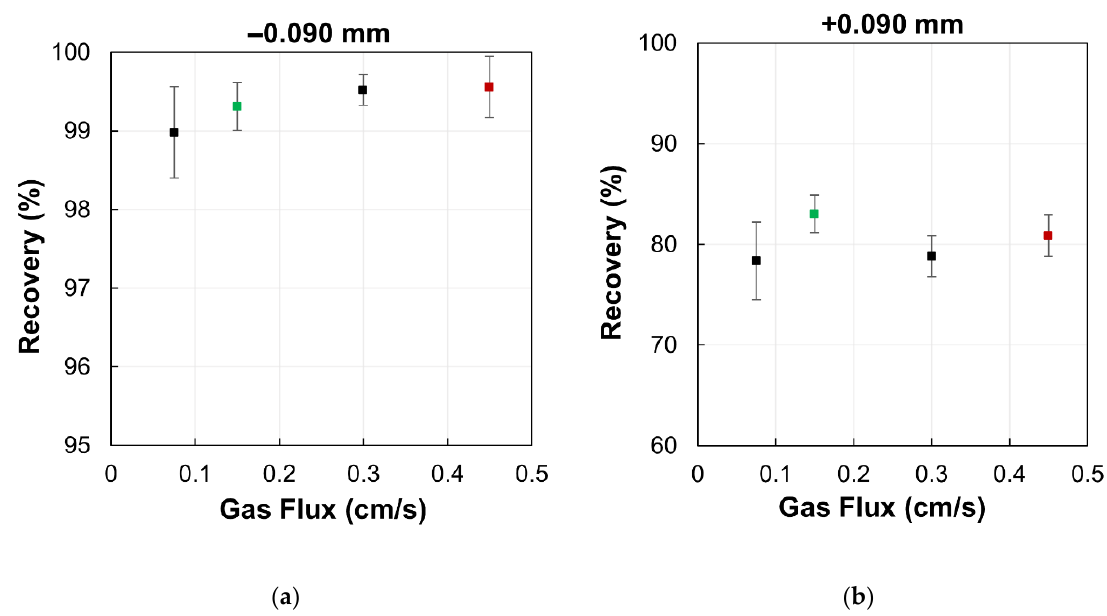
Figure 6. Copper recovery in overflow product as a function of gas flux, split into a fine fraction passing through a screen with sieve aperture of 0.090 mm ( a ) and coarse fraction of +0.090 mm ( b ). Error bars show 95% confidence.